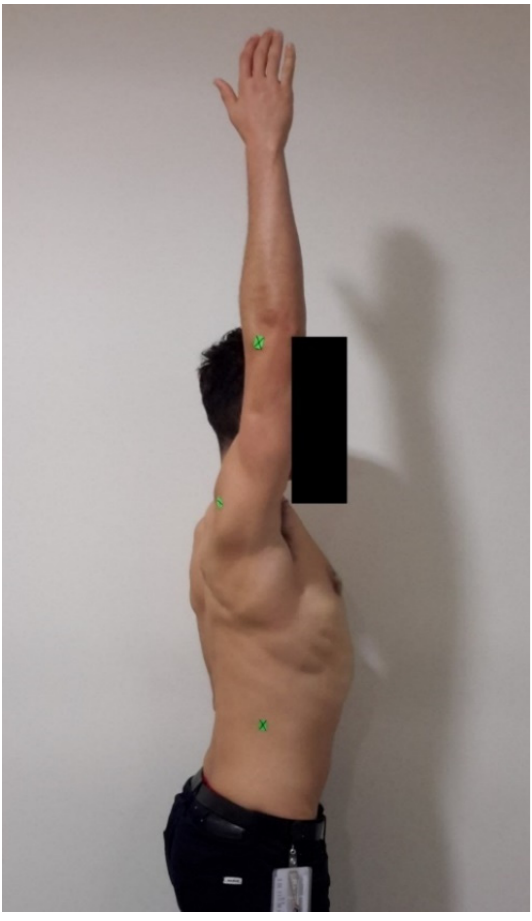
Figure 2. Landmarks for forward flexion ROM as per Ginn et al. [12]. Int. J. Environ. Res. Public Health 2022 , 19 , x FOR PEER REVIEW